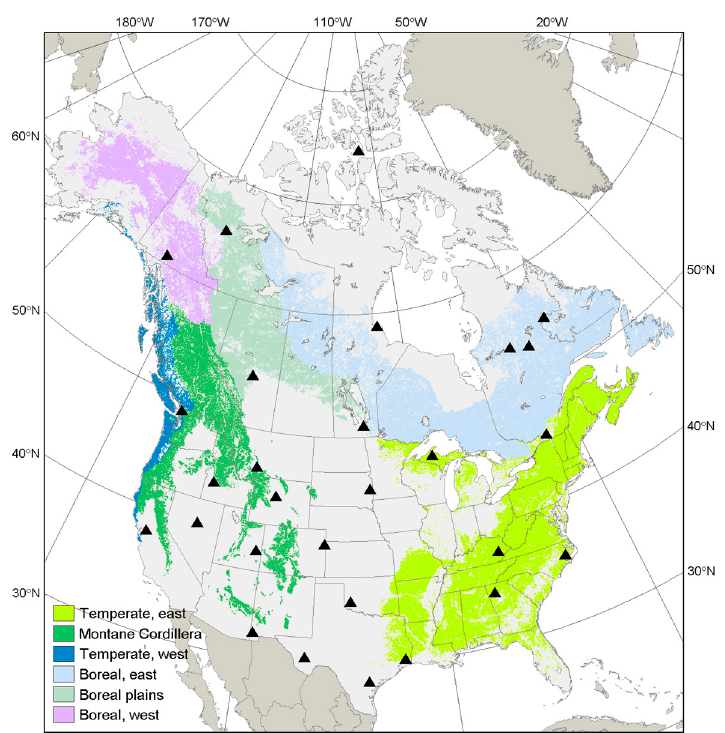
Figure 1. Location of 28 stations with pan evaporation measurements where it was possible to reconstruct meteorological variables (either from measurements at the local climate station, or from climate stations within 50 km of the pan evaporation measurements). The map also identifies the six forest ecozones for which mean trend estimates of potential evaporation from model predictions were reported.